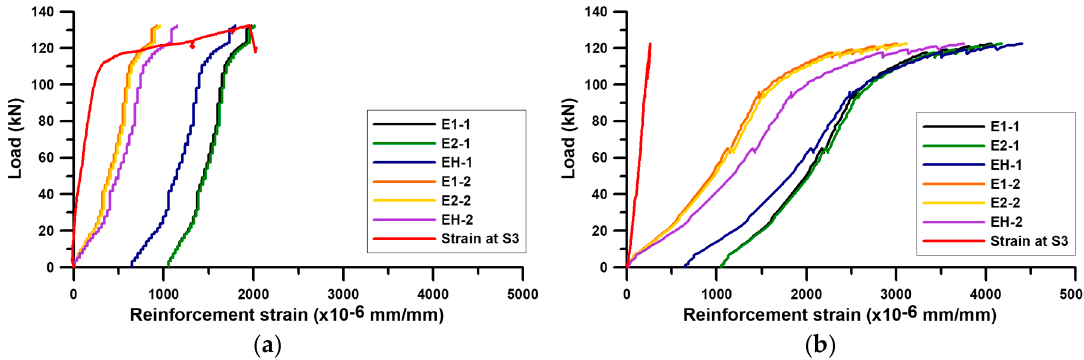
Figure 7. Estimated steel reinforcement strain: ( a ) integral specimen; ( b ) modular specimen.